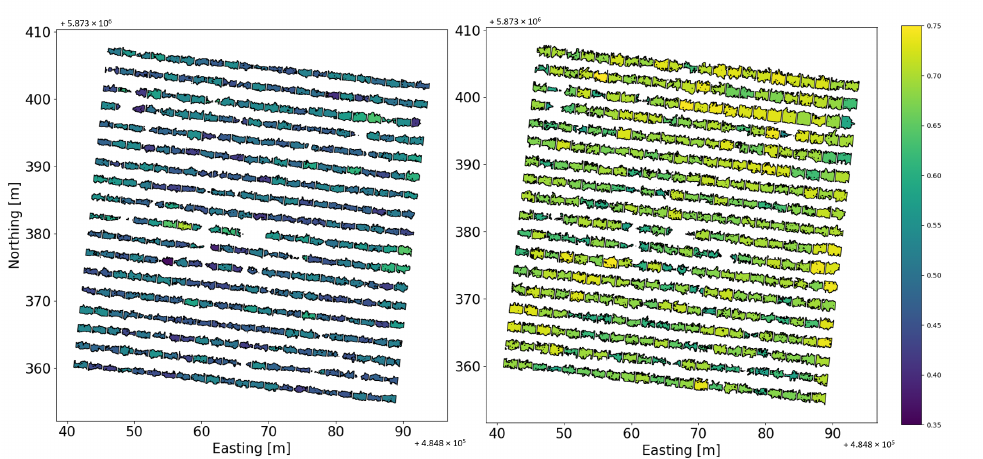
Figure 8. The map of estimated k c values and at the early season (( left ) pane, flowering stage, EL-19) and late season (( right ) pane, post véraison, EL-35) of Cabernet